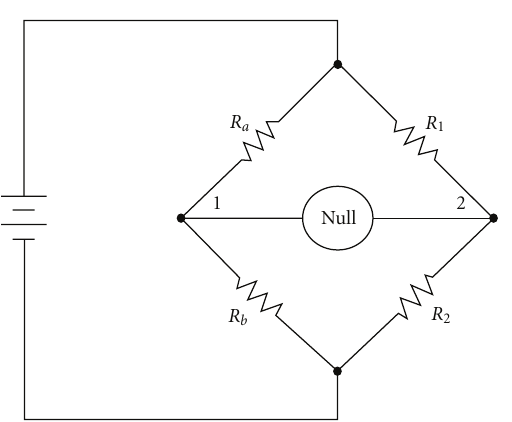
Figure 1: Traditional EDR “null